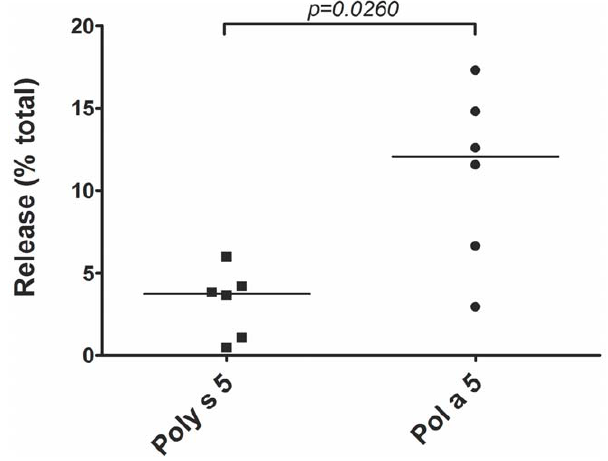
Figure 2. Determination of Poly s 5 allergenic potential. RBL N cells were loaded with IgE from mice immunized with Poly s 5 ( & ) or ) and then exposed to the corresponding autologous Ag 5. Pol a 5 ( Each symbol represents an individual serum. Percentages of b - hexosaminidase release are displayed. Statistical analysis was performed using a non-parametric Mann–Whitney U-test to compare release between the groups.